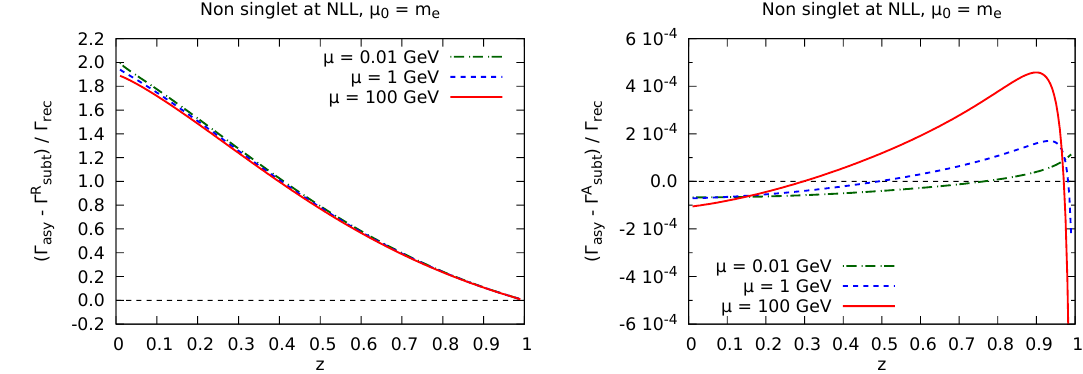
Figure 2 . Same as in (cid:12)gure 1, for eq. (7.10). As is indicated, the scale on the y axis of the plot on the right panel is in units of 10 (cid:0) 4 .